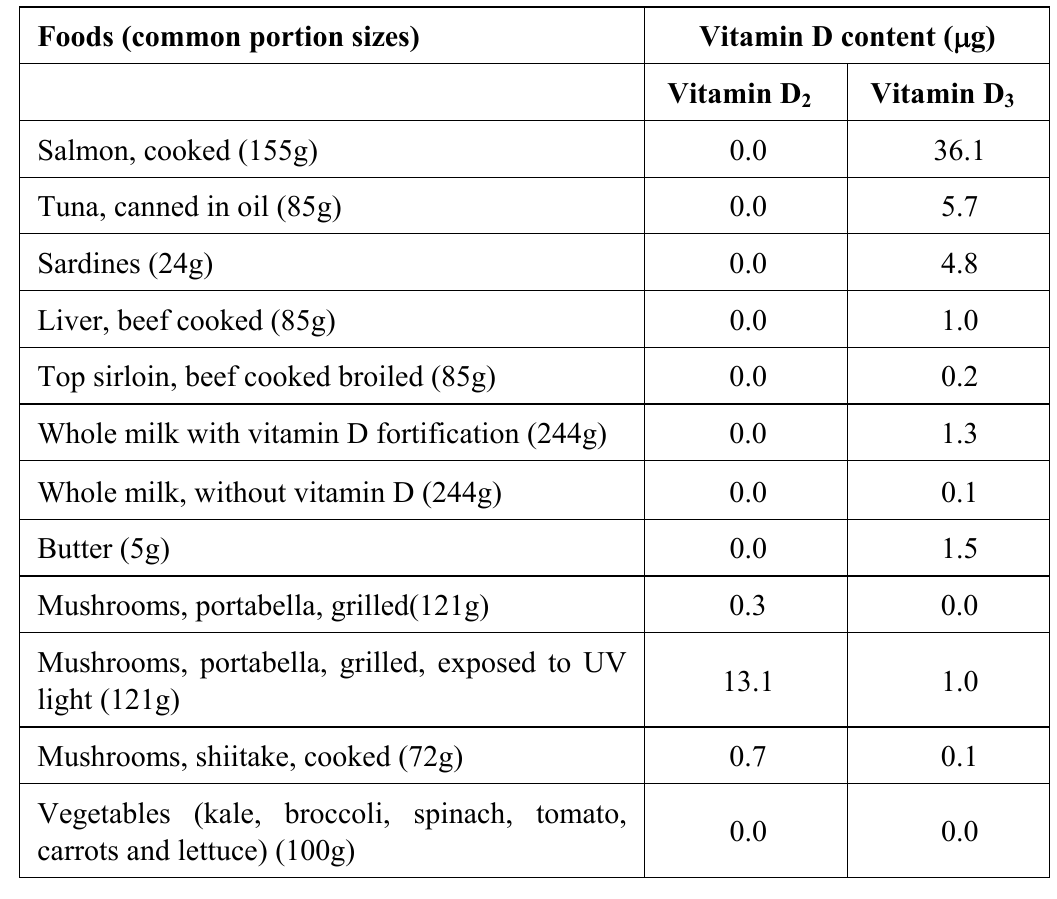
Table 1. Vitamin D and D content in selected foods, adapted from the USDA national 2 3 nutrient database for standard reference, Release